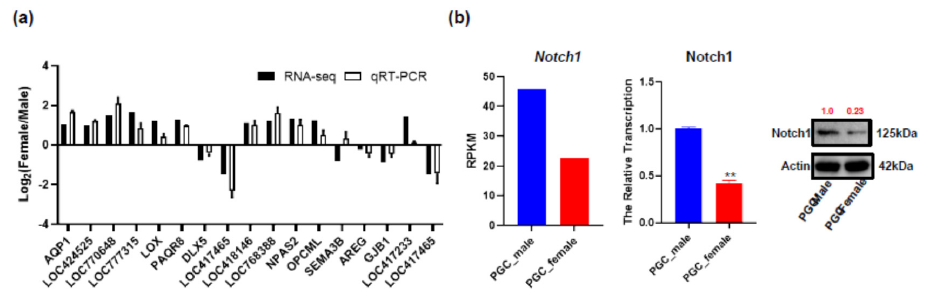
Figure 4. Validation of transcriptome data by real-time qRT-PCR and Notch1 specific expression in male PGCs. ( a ) Expression comparisons of selected genes detected by RNA-Seq and qRT-PCR between amphoteric ESCs and PGCs. The y -axis shows log2 (fold differences) determined by RNA- Seq and qRT-PCR. The experiments were repeated three times and provided consistent results. The mean values and error bars were obtained from three biological and three technical replicates; ( b ) the expression of Notch1 in amphoteric PGCs: the RPKM values of RNA-seq result (left), the expression level of RNA (RT-qPCR, medium) and protein (Western blot, right) results of amphoteric PGCs. All experiments were repeated three times and provided consistent results. The mean values and error bars were obtained from three biological and three technical replicates. The red number in Western Blot presents normalized intensity. 4. Discussion In this study, we conducted the transcriptomic gene expression analysis of amphoteric ESCs and PGCs in chickens. No genes were differentially expressed in amphoteric ESCs; however, differentially expressed genes were identified in amphoteric PGCs and also found to be highly enriched in significant GO terms and KEGG pathways. Moreover, we confirmed that Notch1 is highly expressed in male PGCs. Genetic sex determination in mammals and birds occurs at fertilization with the differential inheritance of sex chromosomes. However, sex determination and differentiation are complicated processes that occur during embryonic development [28,29]. As omnipotent or pluripotent cells, ESCs, especially chicken ESCs, have been reported to resemble mice ESCs, which retain the stage of naive and primed [30–32]. Regarding mice, expression patterns in males and females vary in germ cells, which indicated that sexual dimorphisms occur in mouse ESCs [33]. However, our finding showed that chicken amphoteric ESCs share a great number of genes and have similar expression patterns, which indicates the homogeneity and highly undifferentiated stages of chicken amphoteric ESCs. Although the sex of both chickens and mice is controlled by sex chromosomes (W/Z or X/Y system), the sex determination in chickens is still elusive because of the absence of X chromosome inactivation [34–36]. We propose that might exhibit a potential specific mechanism cause the different expression patterns in amphoteric ESCs between chickens and mice. Genital ridges are precursor organs of gonads (ovary and testis) containing PGCs and somatic cells [37–39]. In gonads, the transition of germ cells from PGCs to sperm cells or eggs is not determined by the genotype but by the somatic cell type of gonads [40,41]. The RNA-seq data revealed sexually dimorphic gene expression in gonad (genital ridge) tissues (day 4.5) before gonadal differentiation (day 6), including some sexual differentiation genes such as FOXL2 [19]. In this paper, the amphoteric PGCs initiate dimorphic gene expression, but these DEGs not including known or putative sex genes. Compared with gonad tissues at day 4.5, amphoteric PGCs represent lower heterogeneity, suggesting the uninitiated germ cell sex determination. A recent study has demonstrated that the amphoteric chicken PGCs could be induced by spermatogonial stem cells (SSCs) or oocytes via co-culture with sertoli cells or granulosa [42–44], which showed that PGC sex differentiation could be activated by somatic cells; this may explain different expression patterns of amphoteric gonad tissues with PGCs.